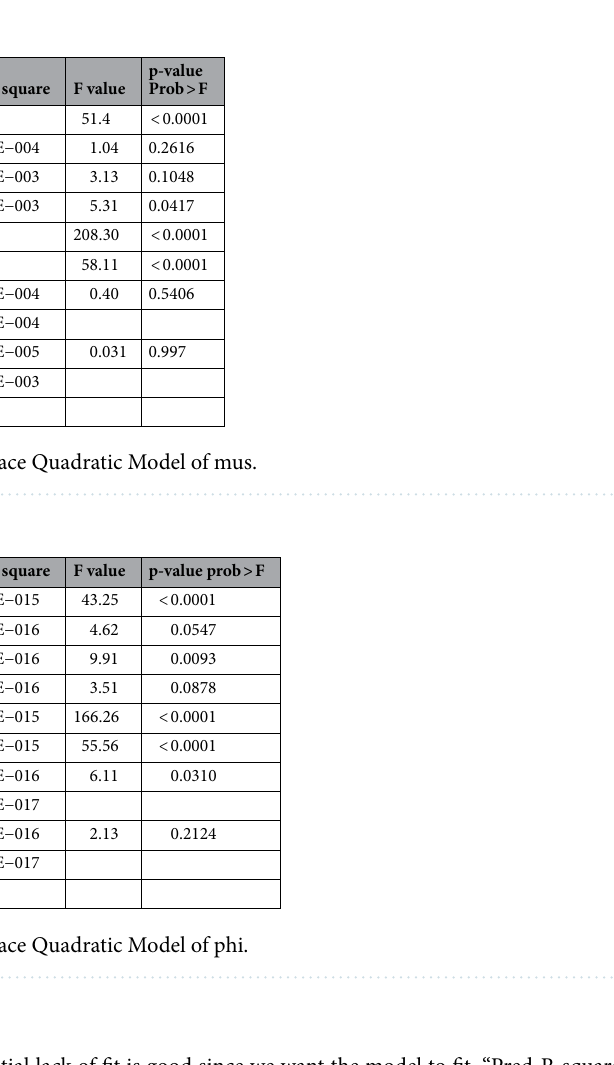
Table 3. ANOVA for response Surface Quadratic Model of mua.